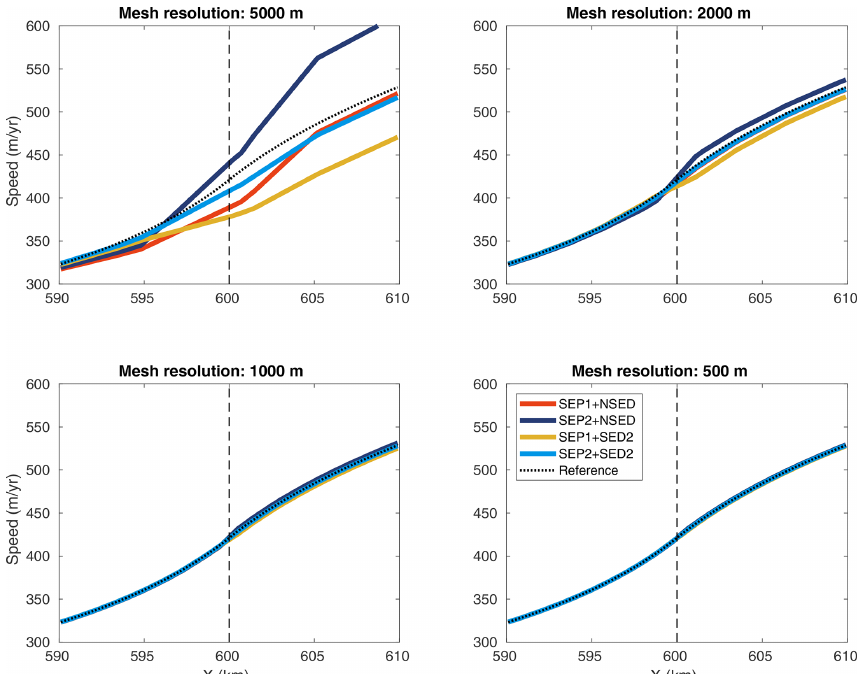
Figure 1. Ice speeds obtained by the diagnostic analysis along a flow line ( y = 25km) and around the grounding line ( x = 600km, dashed line) for different mesh resolutions: 5000, 2000, 1000, and 500m. All sets of sub-element parameterizations are shown: SEP1 + NSED, SEP2 + NSED, SEP1 + SED2, and SEP2 + SED2. The speed from the 50m resolution structured conforming mesh (reference model) is also shown (reference, dotted line).